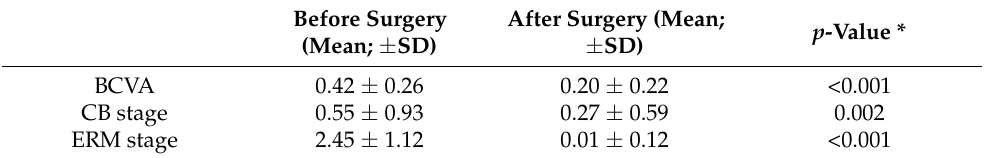
Table 2. Influences of surgery on different parameters. Before